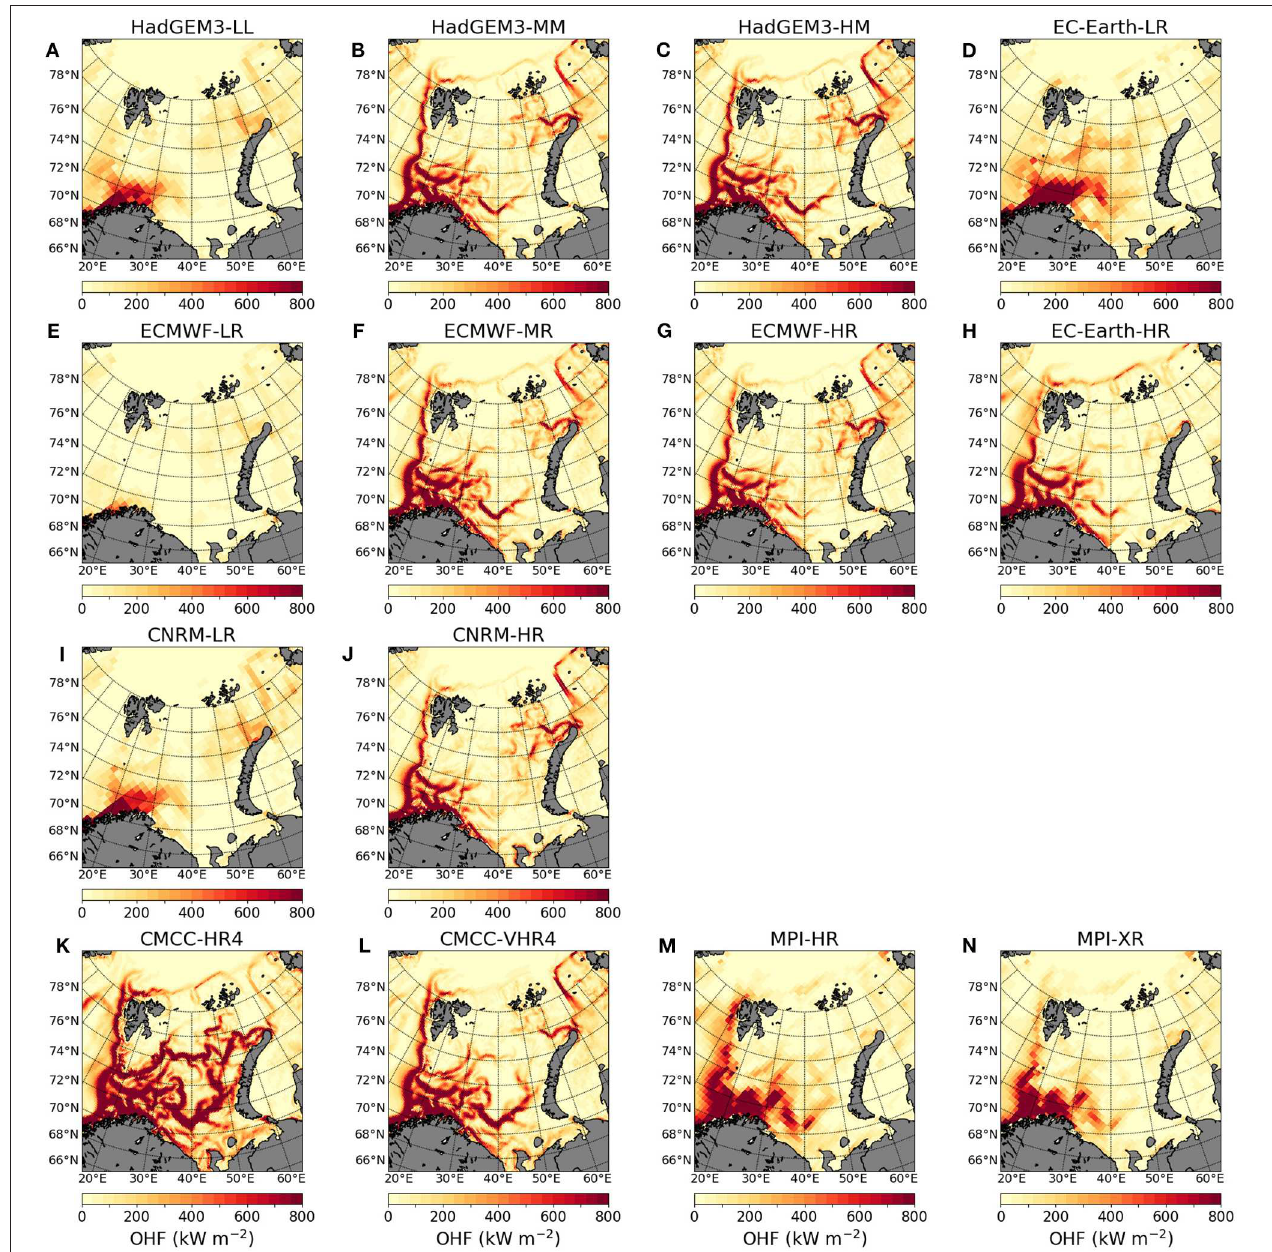
FIGURE 7 | Mean horizontal ocean heat flux (OHF) in the Barents Sea from HighResMIP hist-1950 model outputs, averaged over 1950–2014.